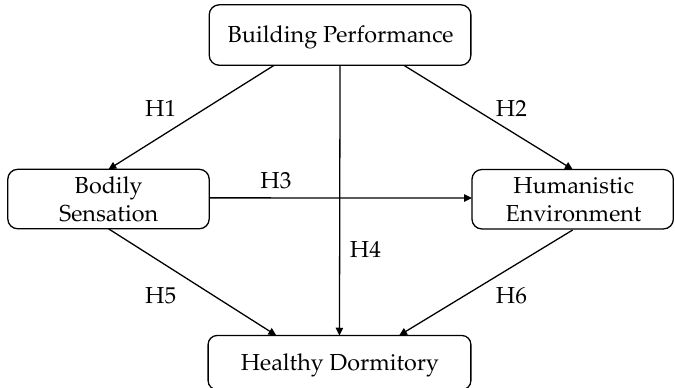
Figure 2. Preliminary theoretical model.